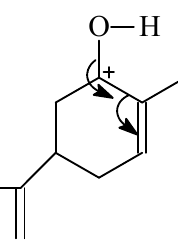
Figure 2. The structure which is formed during the oxidative dehydrogenation of carveol to carvone.